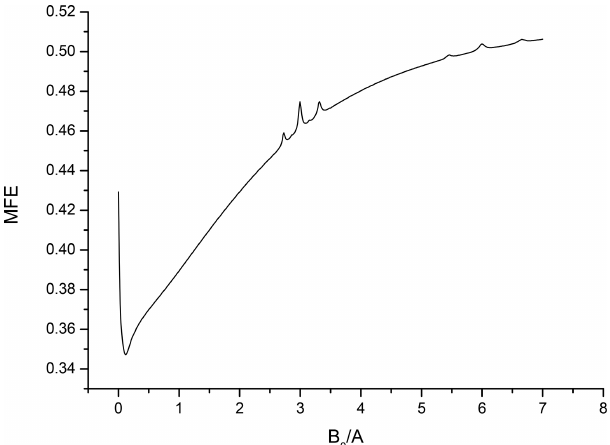
Figure 2. Closeup of the spectrum from Fig. 1 in the vicinity of B 0 = 3 A for two values of the recombination parameter s = A/ 100, s = A/ 400.